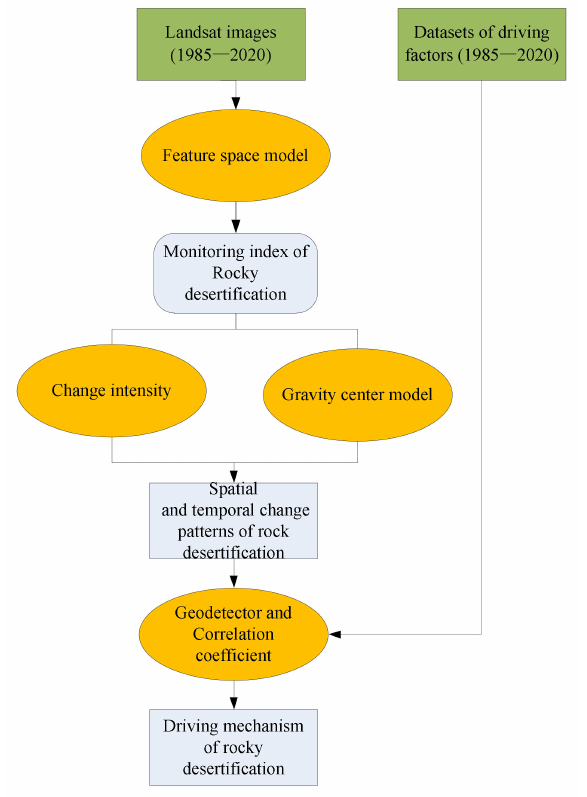
Figure 2. Work flowchart of the